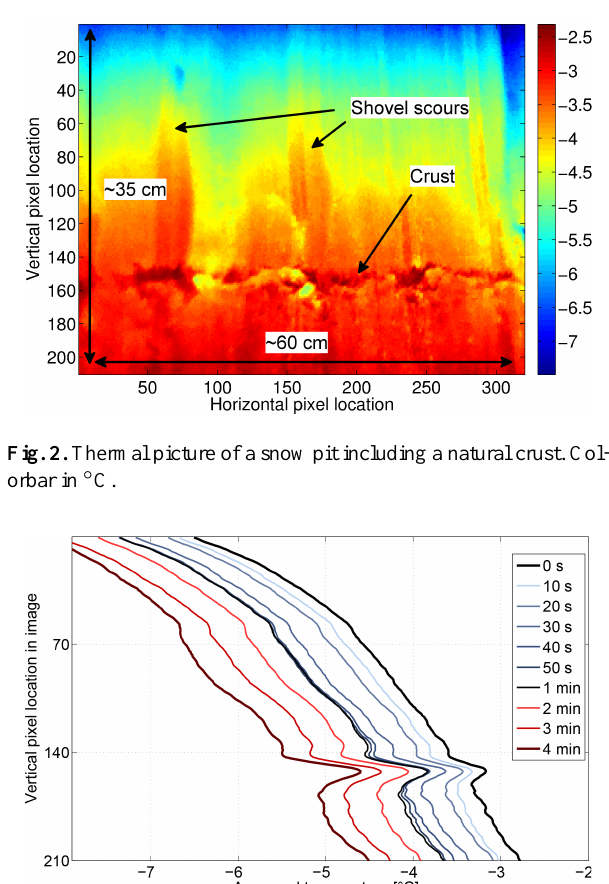
Fig. 3. Mean vertical temperature profiles dependent on time after pit wall exposure. The thick black line represents the situation of Fig. 2.